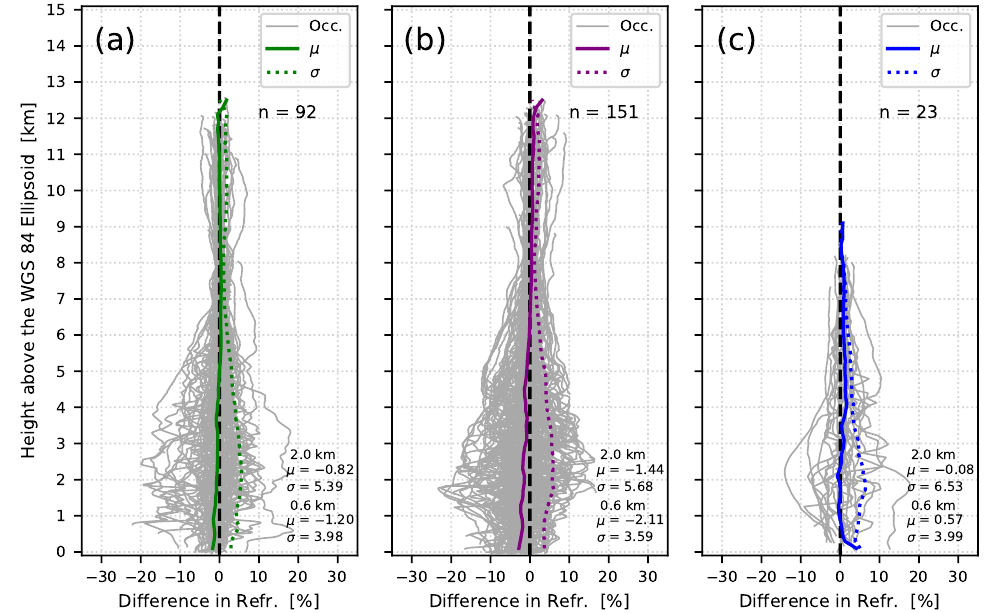
Figure 10. Same as Figure 5 but for occultations and their nearest dropsonde that were within a distance threshold of 500 km and a time threshold of 4